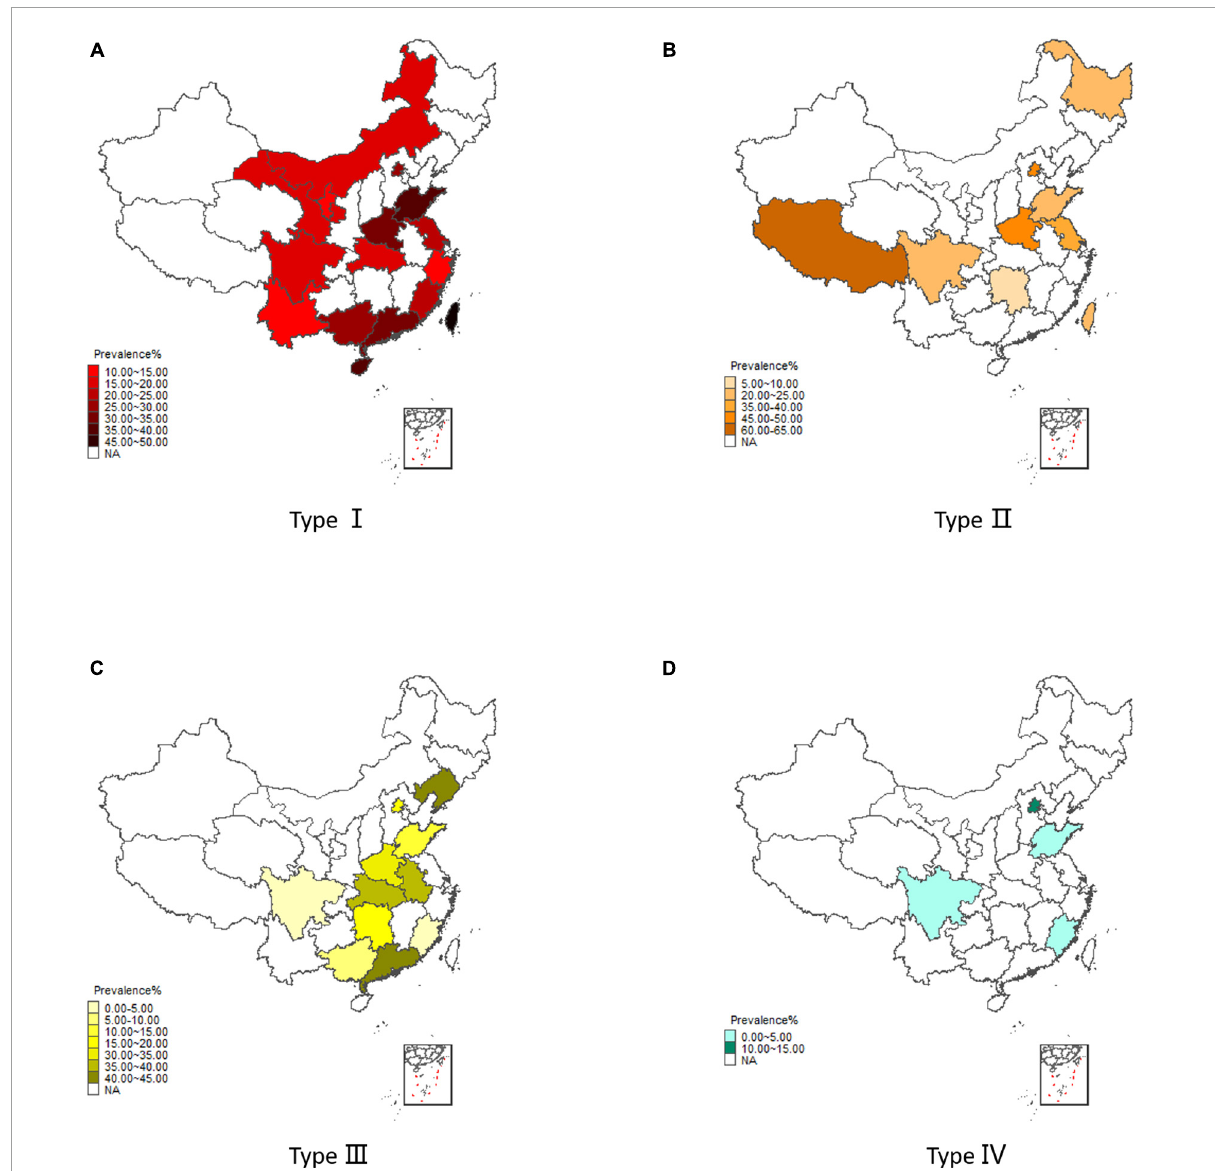
FIGURE3 Regional distribution for prevalence of violence. (A) Results of type I. (B) Results of type II. (C) Results of type III. (D) Results of type IV.